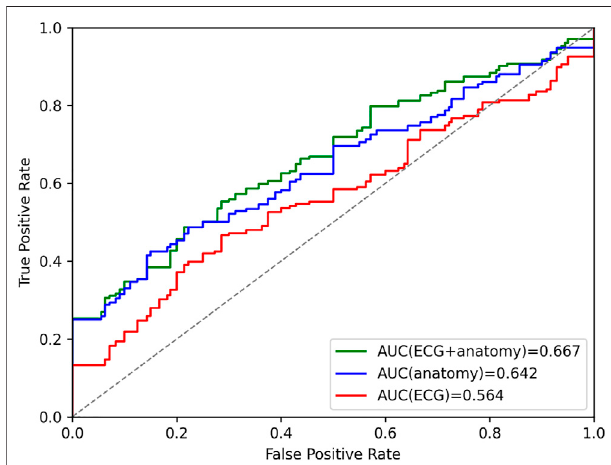
FIGURE 6 | Area under curve (AUC) prediction differences in ROC curves of the cardiac disease classi fi cation results based on latent space representations of VAEs trained on combined anatomy and ECG, only anatomy, and only ECG